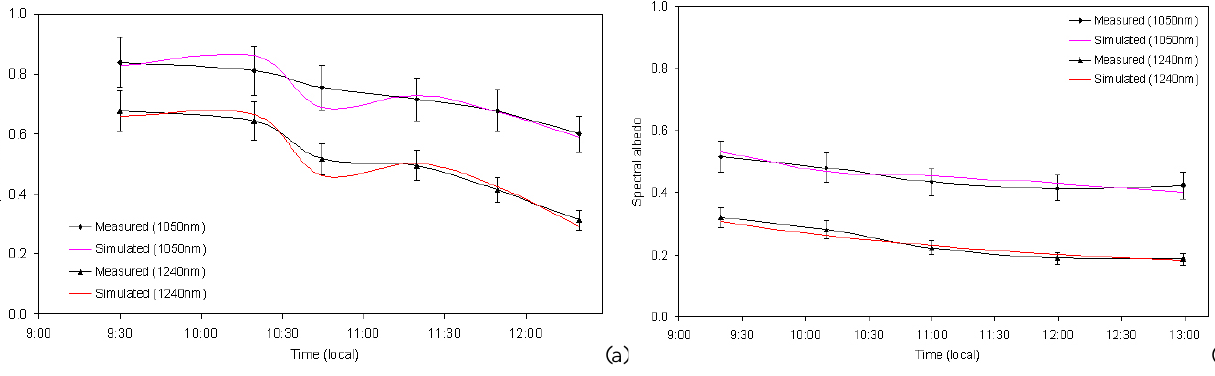
Fig. 6. The comparison between simulated temporal plane albedo and field measured spectral albedo with 10% differences at wavelength 1.05µm and 1.24µm for (a) snow Type-I and (b) snow